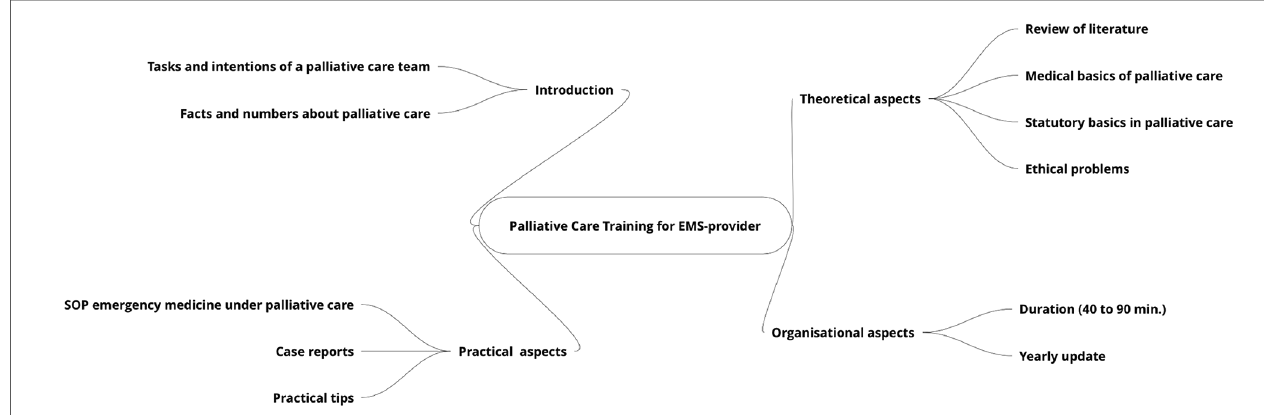
FIGURE 4 Needs for a special pediatric palliative care training/summary of participant